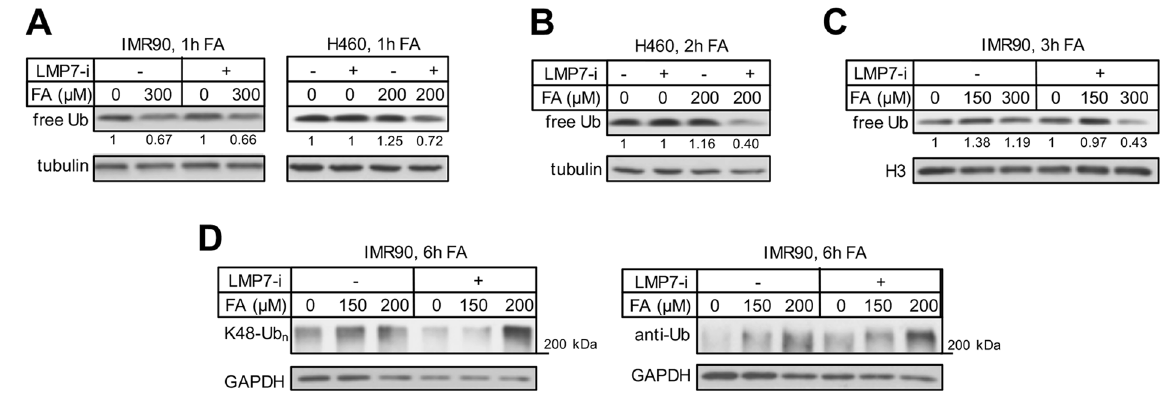
Figure 8. Ubiquitin reserves and protein polyubiquitination. Panels A–C: whole cell lysates were used for westerns and LMP7-i was added at 0.3 μ M. ( A ) Free ubiquitin in cells treated with FA for 1 h with and without LMP7-i. ( B ) Free ubiquitin in H460 cells treated with FA + / − LMP7-i for 2 h and ( C ) IMR90 cells treated with FA + / − LMP7-i for 3 h. ( D ) K48-linked (K48-Ub n ) and overall polyubiquitination (anti-Ub) of cytoplasmic proteins in IMR90 cells treated with FA + / − LMP7-i (0.2 μ M) for 6